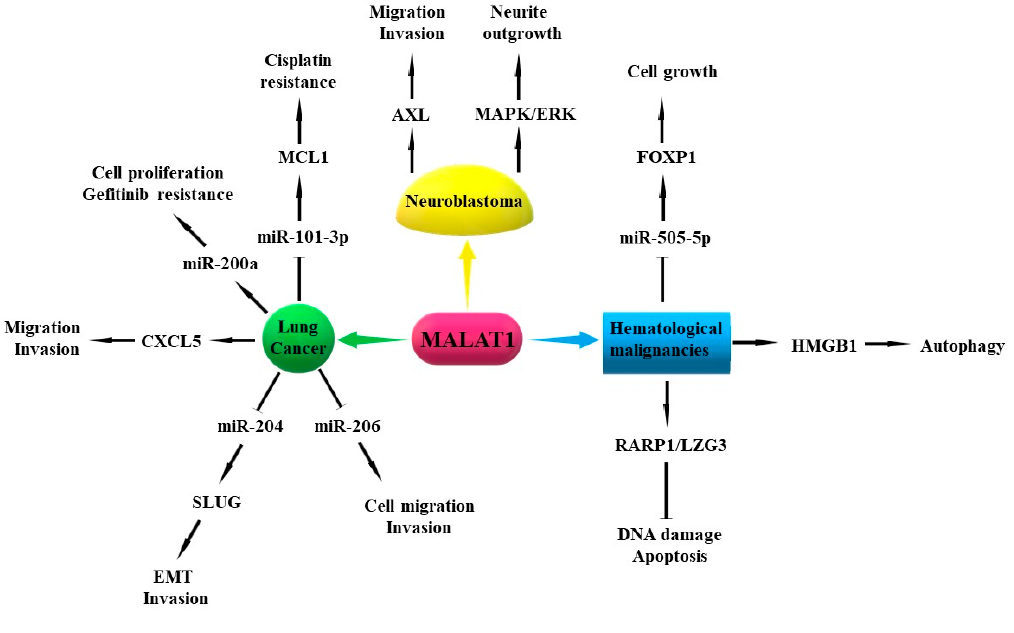
Figure 1. Proposed mechanisms of MALAT1 in various cancers .